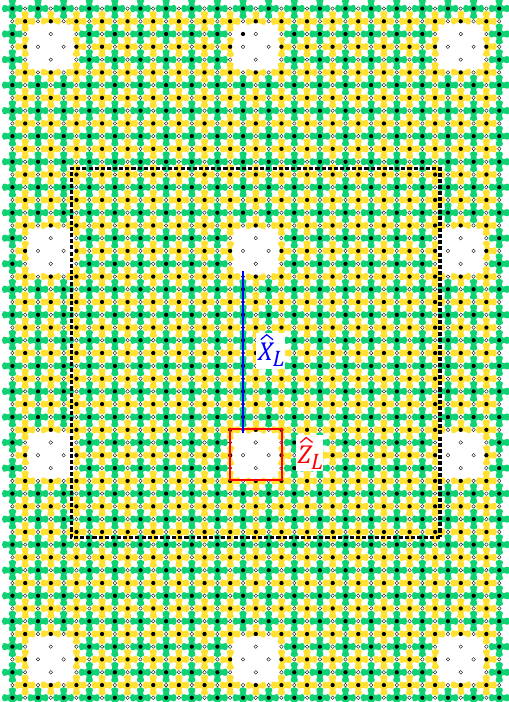
Figure 41: Executing the logical Hadamard. The spacing and size of the Z-cut qubit holes corresponds to a distance d = 7. The two holes in the center of the array form the logical qubit that is the target for the logical Hadamard, and for which we display the X logical operators. The dashed box outlines the limits for what is shown in Figs. 42 and 43. Figure from Ref. (Fowler, Mariantoni, Martinis and Cleland,